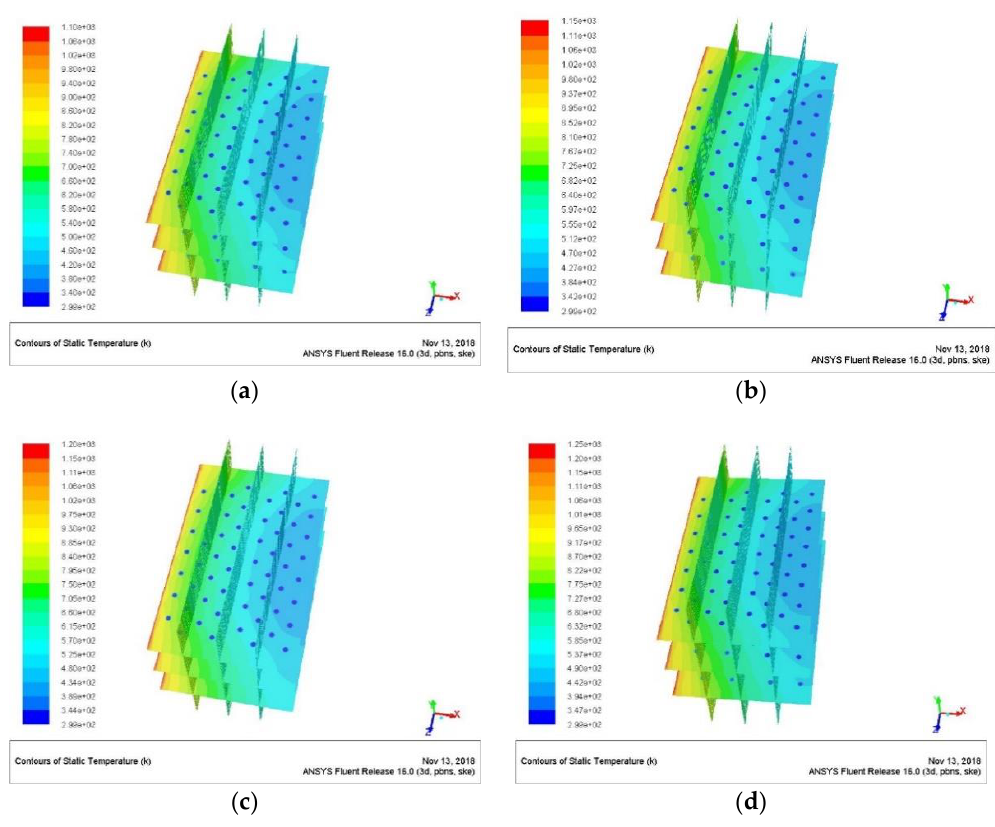
Figure 7. Temperature distribution under different inlet flue gas temperatures in granular bed. ( a ) Inlet flue gas temperature was 1100 K. ( b ) Inlet flue gas temperature was 1150 K. ( c ) Inlet flue gas temperature was 1200 K. ( d ) Inlet flue gas temperature was 1250 K